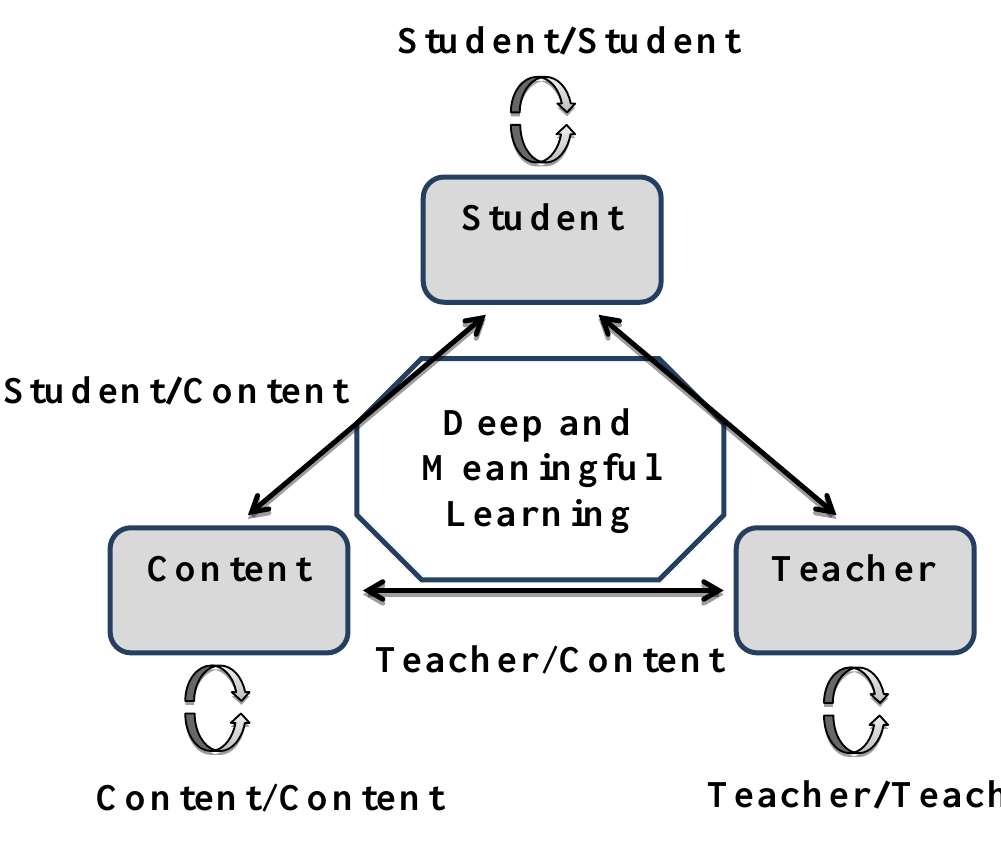
Figure 1 . The interaction theory typology (Garrison & Anderson, 2003,